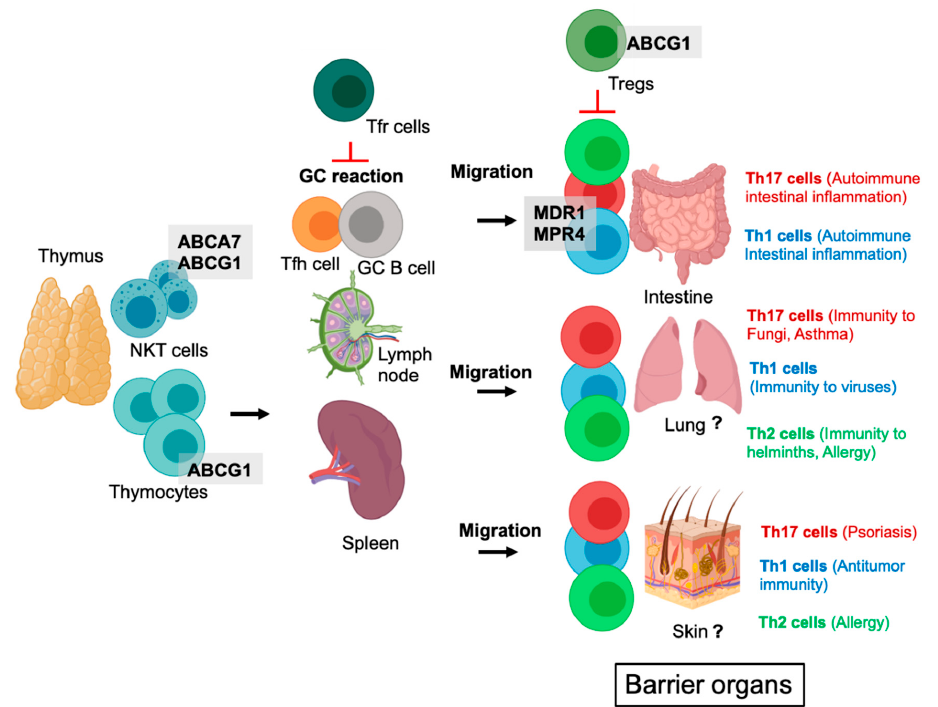
Figure 3. ABC transporters regulate the function of different T cell populations. Abbreviations: NKT, Natural Killer T cell; Tfh cells, T follicular helper cells; Tfr cells, T follicular regulatory cells; GC, Germinal center; Tregs, regulatory T cells; Th cell, T helper cell. MDR1, Multidrug-resistance-protein-1; MPR4, Multidrug-resistance-associated-protein-4.